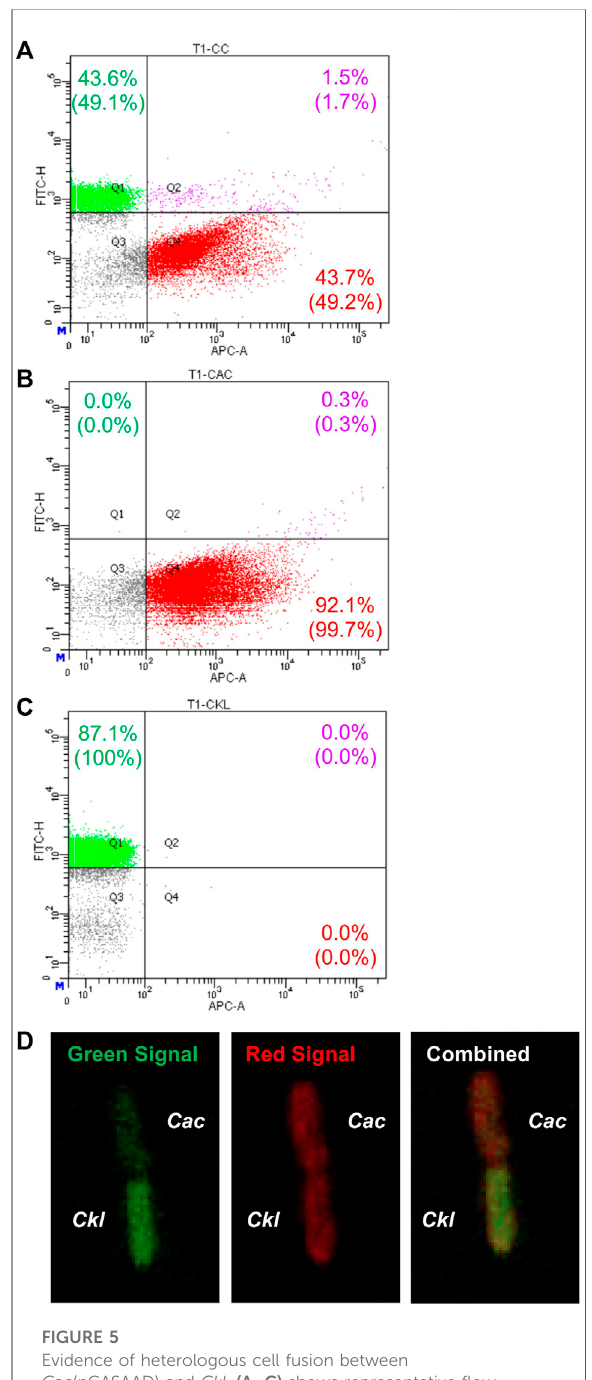
FIGURE 5 Evidence of heterologous cell fusion between Cac (pCASAAD) and Ckl . (A – C) shows representative fl ow- cytometric pro fi les of a Cac (pCASAAD)/ Ckl coculture using stained cells. Cac cells were stained with CTDR, which expresses red fl uorescence and can be seen in the APC channel. Ckl cells were stained with CTG, which expresses green fl uorescence and can be seen in the FITC channel. (A) is the coculture, (B) is the Cac monoculture, and (C) is the Ckl monoculture. The percentageswithoutparentheses represent the total number of cells, and the percentages within parentheses representthenormalized valuesofonly fl uorescentcells.Notethe group of double-positive cells in Q2 of the coculture panel. (D)